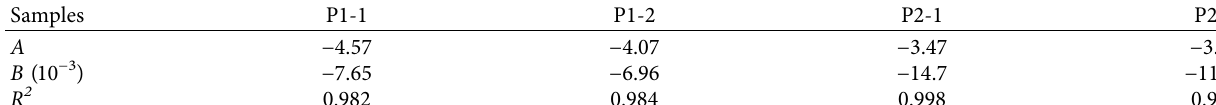
Table 3: Values of coefficients A and B and correlation coefficient R 2